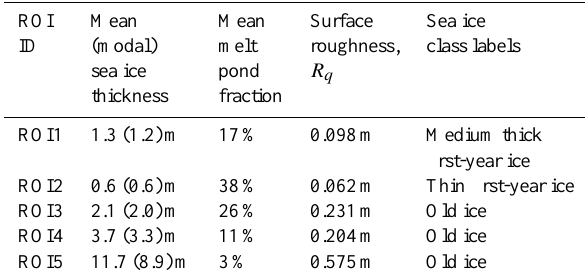
Table 2. Detailed information about the regions of interest (ROIs) from helicopter-borne measurements and the corresponding sea ice class labels (WMO